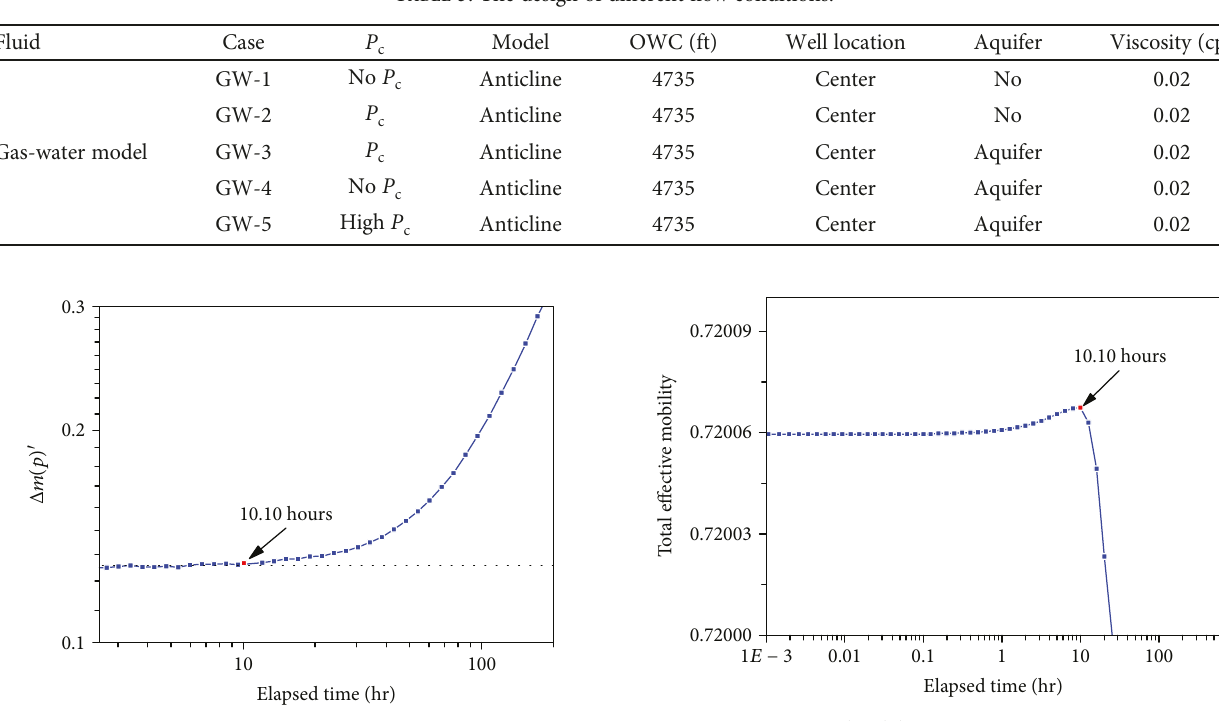
Figure 15: (a) The total mobility curve and (b) the total mobility derivative curve at upstream saturation front with oil viscosity at 1 cp. Although the total mobility has some changes, the total mobility derivative is very small and close to constant in late time. Table 3: The design of di ff erent fl ow conditions.